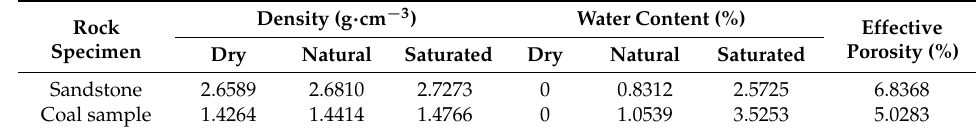
Table 1. Sample physical parameters.